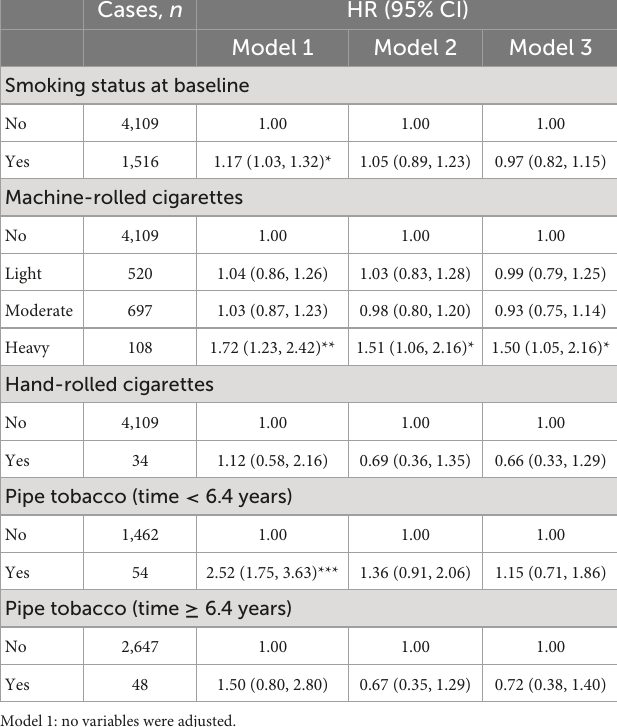
associated with smoking status. Cases, n